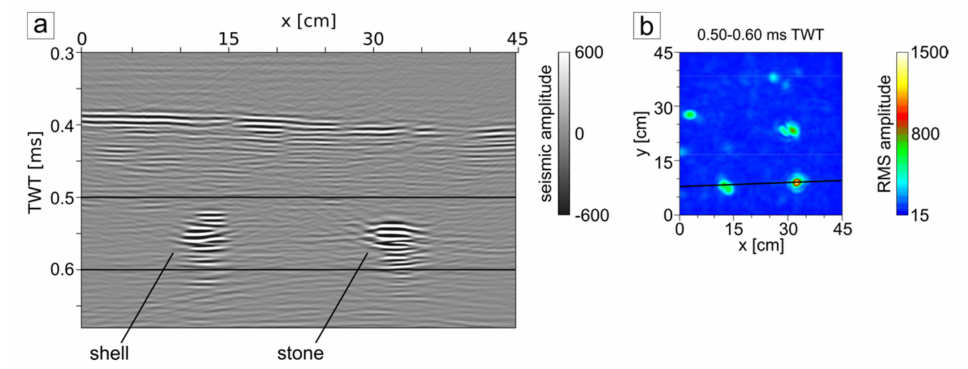
Figure 8. ( a ) Seismic profile showing the reflections of a shell (with outside facing upward) and a stone of comparable size. Amplitudes of the stone reflections are higher than the reflections of the shell, which appears to be more diffuse. The location of the seismic profile is indicated in ( b ). ( b ) RMS amplitudes of the corresponding time range (depth is indicated in ( a )), showing a much higher amplitude for the stone than for the shell. The diameter measured in the time slice is 2.5–4.0 cm for the shell (2.9 × 3.2 × 1.0 cm), and 3.0–3.4 cm for the stone (3.2 × 2.2 × 1.0